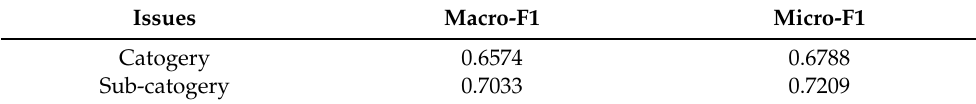
Table 8. Macro-average and micro-average measures for multi-layer multi-class SVM